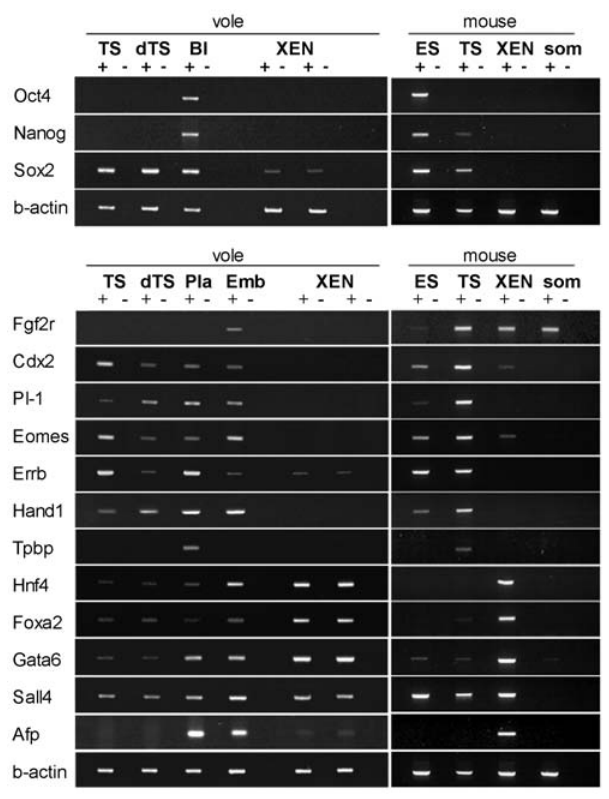
Figure 3. RT-PCR analysis of transcription factors expressed in vole TS-like cells. Transcription factors specific for mouse germ layers and expressed in three TS-like cell lineages: embryonic (ES), extraem- bryonic ectoderm (TS) and extraembryonic endoderm (XEN). (Bl) 4.5 dpc vole blastocyst; (Pla) 12.5 dpc vole placenta; (Emb) vole embryos at 7.5 dpc; (som) mouse somatic cells.